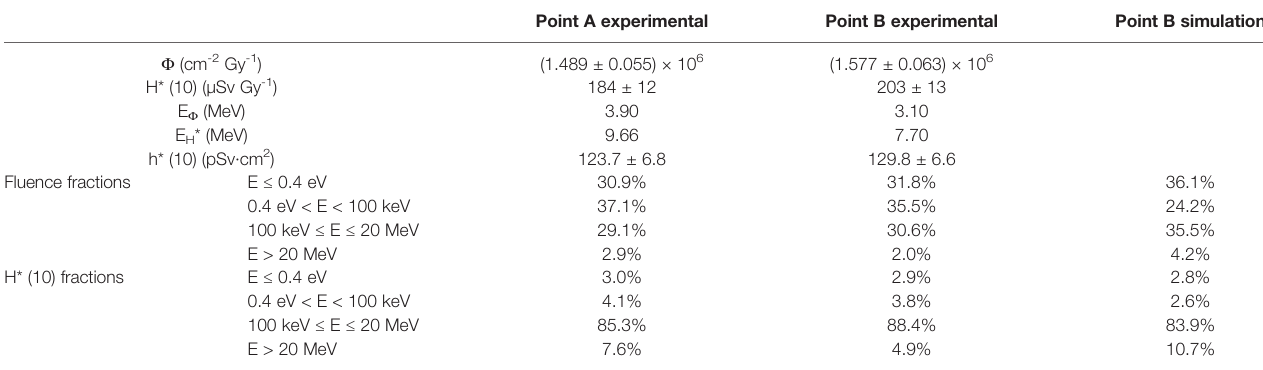
TABLE 3 | Neutron fl uence, ambient dose equivalent, fl uence-averaged energy, dose equivalent-averaged energy, and average fl uence to ambient dose equivalent conversion coef fi cient per unit proton dose imparted at the points of measurement inside the treatment room, as well as fl uence and dose equivalent fractions for the different energy ranges from experimental determination and simulation.